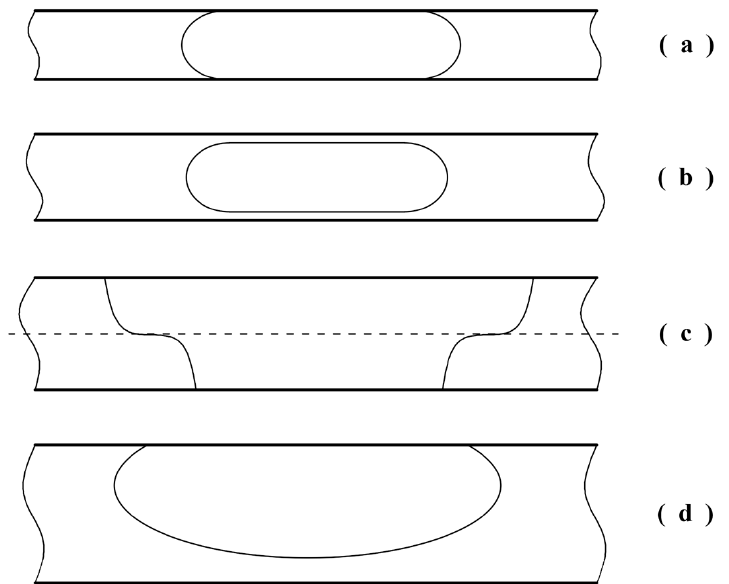
Figure 6. Schematic diagram of gas-liquid interface morphology in longitudinal section of various pipe diameters: ( a ) D-3–4; ( b ) D-5; ( c ) D-6.5; ( d ) D-8.